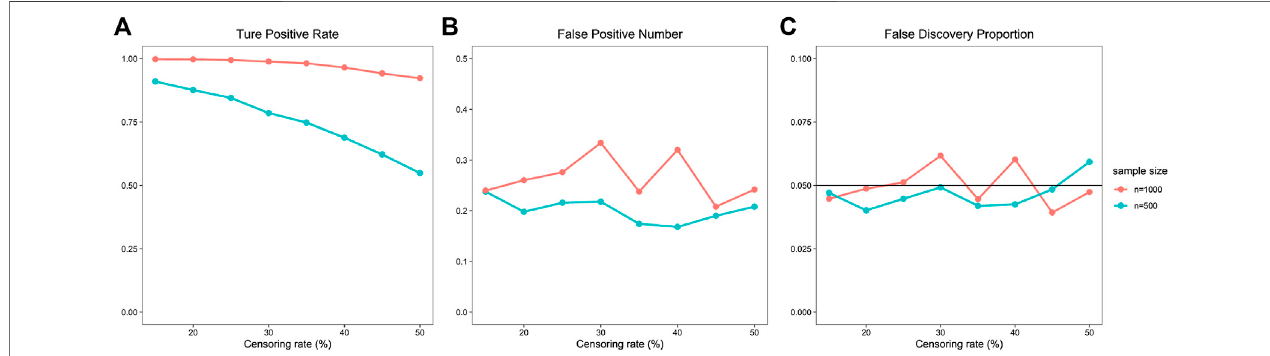
FIGURE 3 | Select accuracy of the proposed procedure. (A) shows TPR variation of the proposed procedure with different censoring rate and sample size, (B) shows FP variation, (C) shows FDP variation.